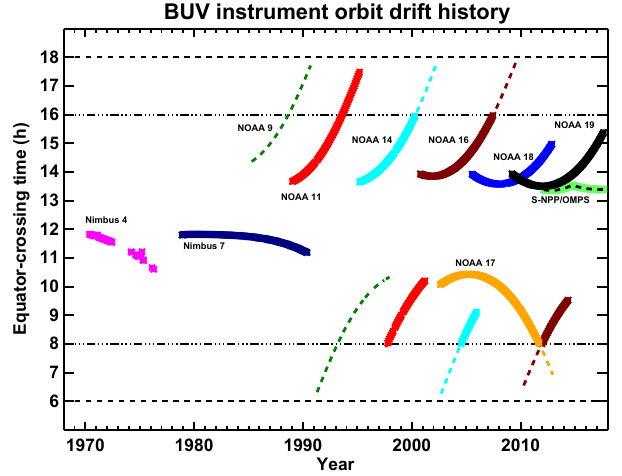
Figure 1. Times series of equatorial crossing time (ECT) for the se- ries of SBUV instruments. The terminator (06:00 and 18:00) ECTs are denoted by black dashed lines, and the 08:00 and 16:00 ECTs are denoted by black dash–dot lines. Thick colored solid lines show segments of data included in MOD; dashed colored lines show the full extent of the instrument record. S-NPP/OMPS is denoted by a solid line with dash overlay to indicate data that will be included in future MOD versions.